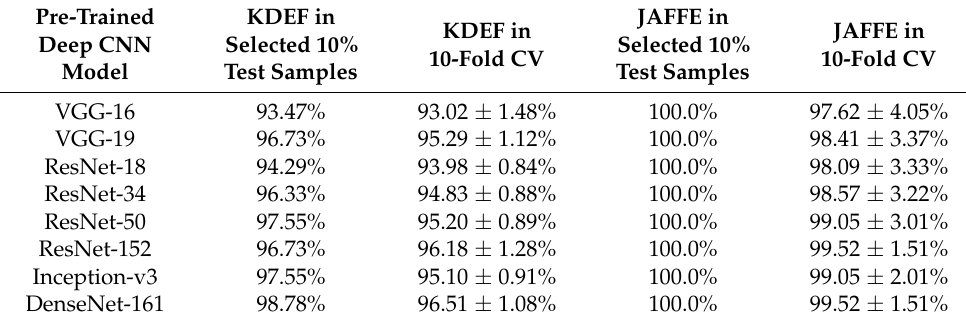
Table 3. Comparison of the test set accuracies with different pre-trained deep CNN models on KDEF and JAFFE